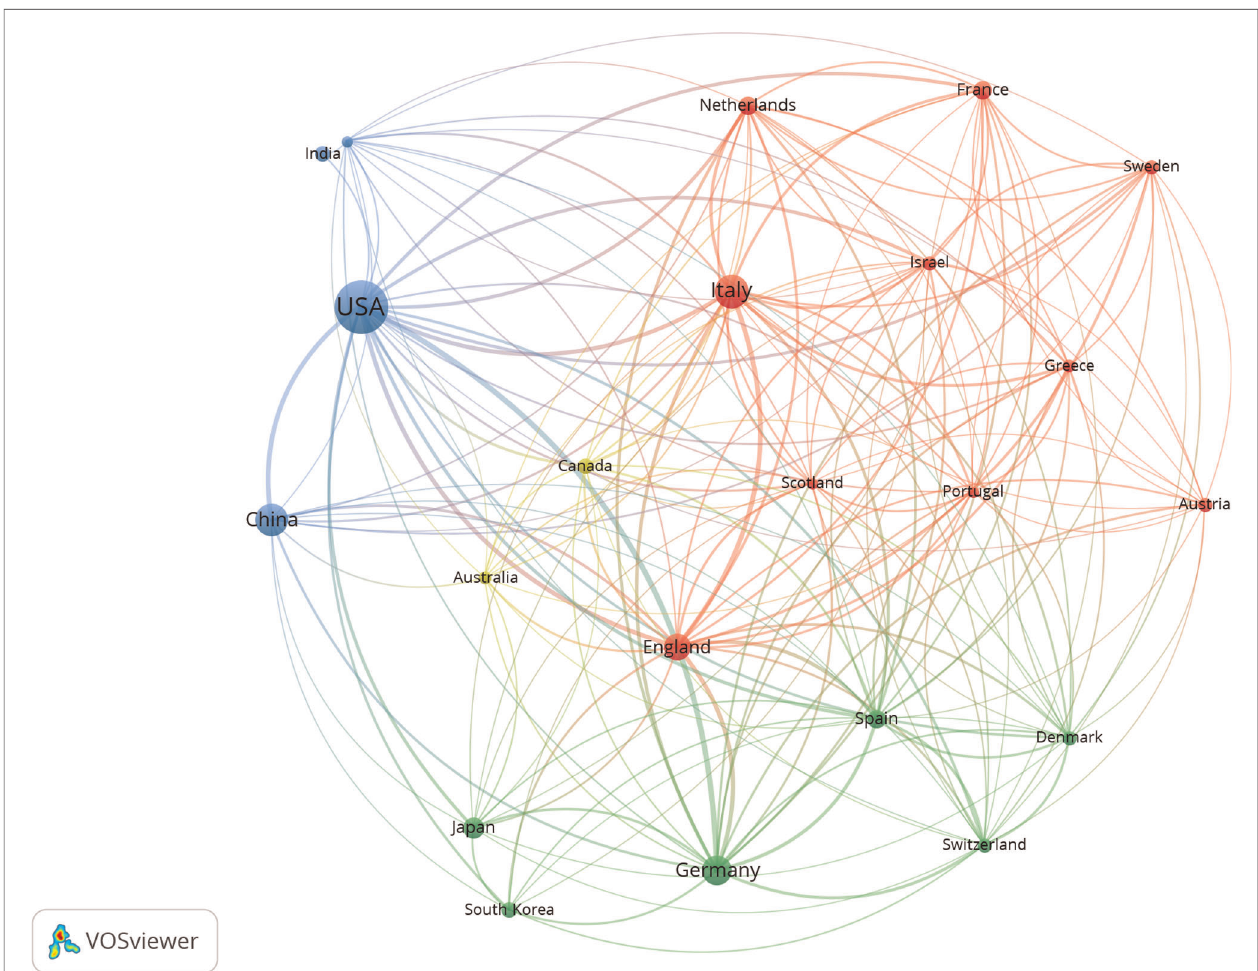
FIGURE 2 | Geographical distribution and collaborations among countries in stem cell precision medicine. The circles represent countries, with the larger circle corresponding to more publications. The connecting lines represent the academic cooperation between countries, with the thicker line corresponding to closer cooperation. Different colors represent different clusters automatically calculated by